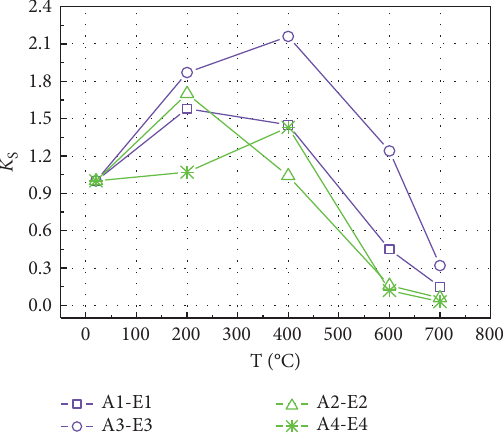
Figure 8: Te relationship between K